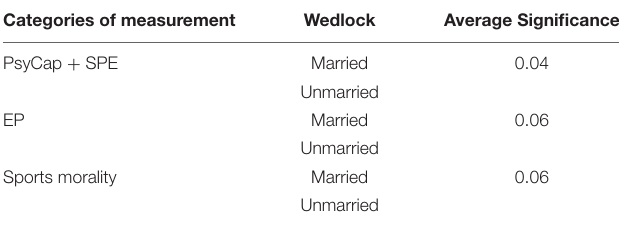
TABLE 10 | Significant differences in wedlock